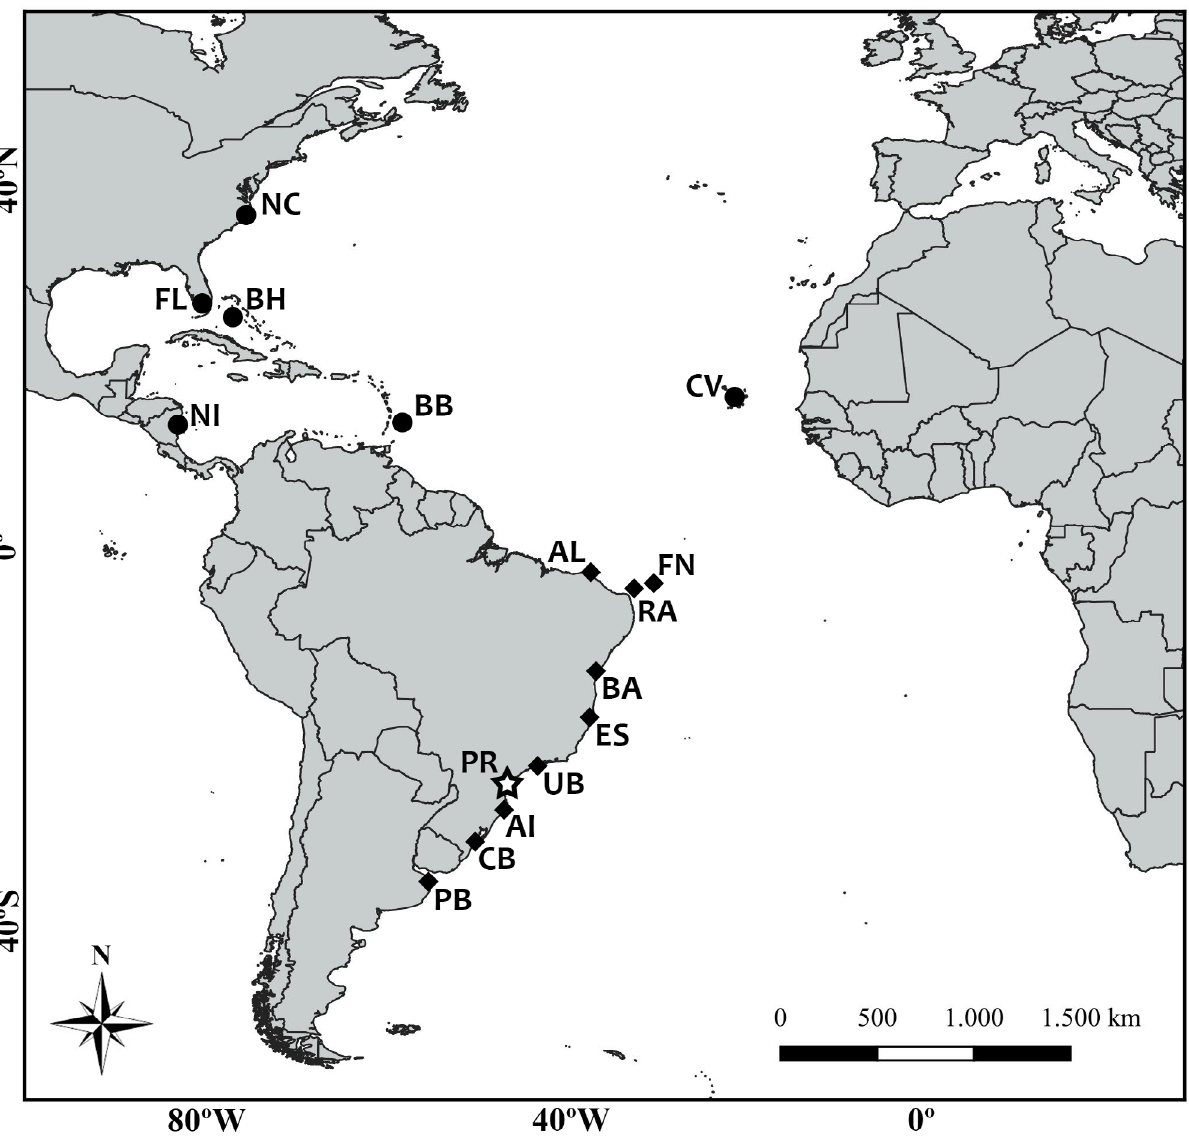
Figure 1 ‒ Map of the sample location on the coast of Paraná (PR), Southern Brazil (symbolized by a star). The other feeding areas of the Atlantic Ocean, the North Atlantic group, including North Carolina/USA (NC), Florida/USA (FL), Bahamas (BH), Nicaragua (NI), Barbados (BB), and Cape Verde (CV) indicated by circles; and the South Atlantic group, including Almofala/BR (AL), Fernando de Noronha/BR (FN), Rocas Atoll/BR (RA), Bahia/BR (BA), Espírito Santo/BR (ES), Ubatuba/BR (UB), Arvoredo Island/BR (AI), Cassino Beach/BR (CB), and Buenos Aires Province/AR (PB) represented by lozenges.